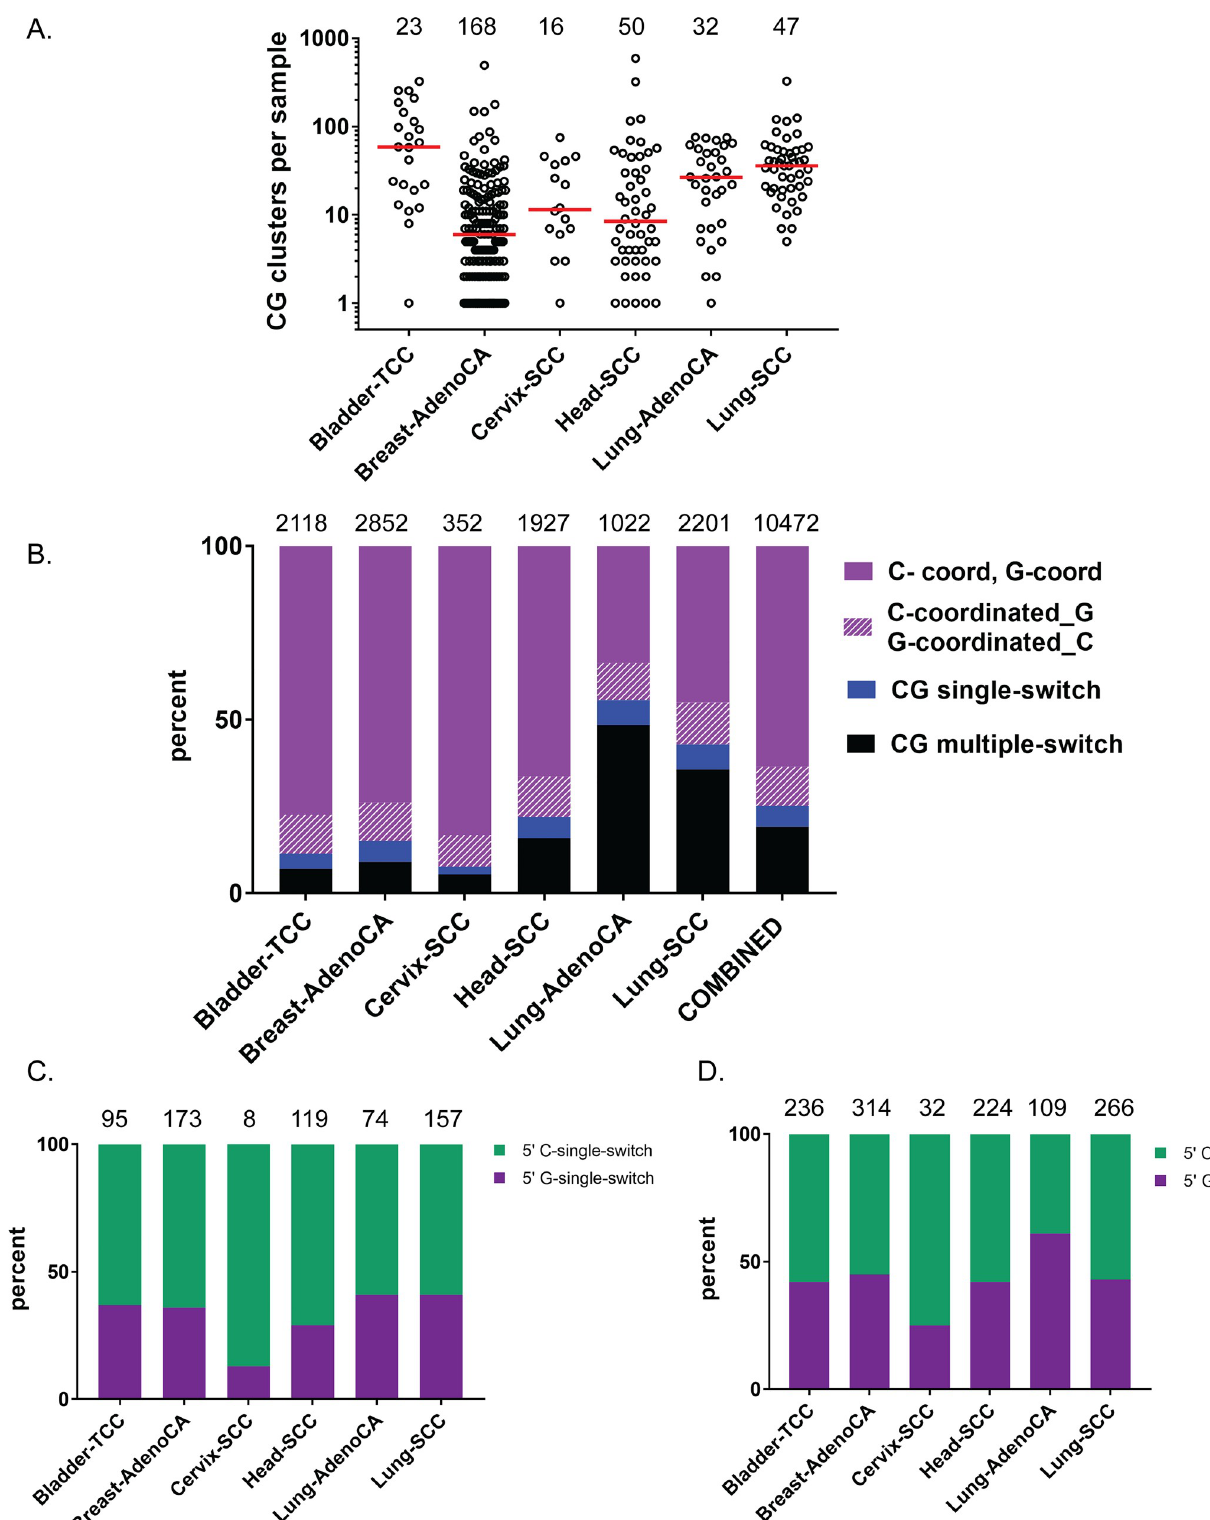
Fig 6. Cluster analysis in highly APOBEC-enriched cancers. Mutation clusters described in this figure were derived from the PCAWG data set [32] and were identified similarly to [5, 19]. Analysis uses only CG clusters with > 3 mutations. (A) Number of CG clusters containing > 3 mutations per